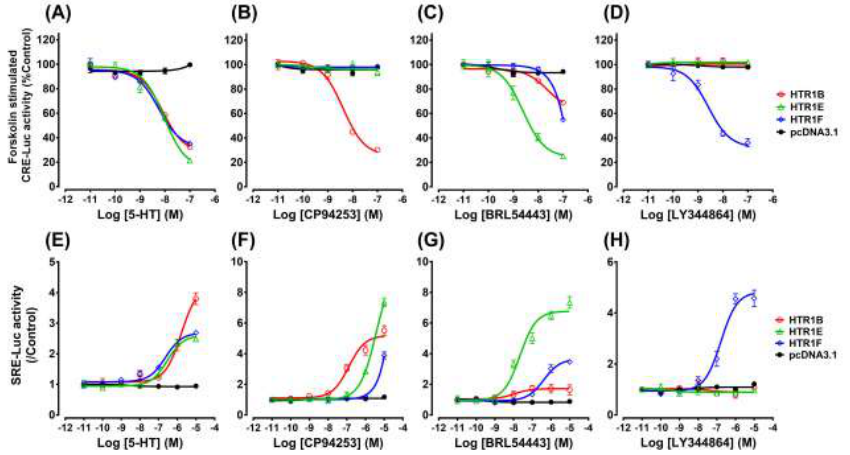
Figure 4. Luciferase activities of HEK293 cells expressing chicken HTR1B, HTR1E, and HTR1F in response to various concentrations of 5-HT (or receptor-selective agonists) treatments. HEK293 cells were transiently co-transfected with HTR1 expression plasmid and pGL3-CRE/pGL4-SRE luciferase reporter construct, and subjected to ligand treatment for 6 h before measurement. Effects of 5-HT ( A ), CP94253 ( B ), BRL54443 ( C ), and LY344864 ( D ) (10 − 11 –10 − 7 M, 6 h) on forskolin (2 µ M)-stimulated luciferase activity of HEK293 cells expressing chicken HTR1B, HTR1E, and HTR1F, monitored by a pGL3-CRE luciferase reporter system. Effects of 5-HT ( E ), CP94253 ( F ), BRL54443 ( G ), and LY344864 ( H ) (10 − 11 –10 − 5 M, 6 h) on luciferase activity of HEK293 cells expressing chicken HTR1B, HTR1E, and HTR1F, monitored by a pGL4-SRE luciferase reporter system. HEK293 cells co-transfected with empty pcDNA3.1(+) and luciferase reporter construct were used as a control. Each data point represents the mean ± SEM of 3